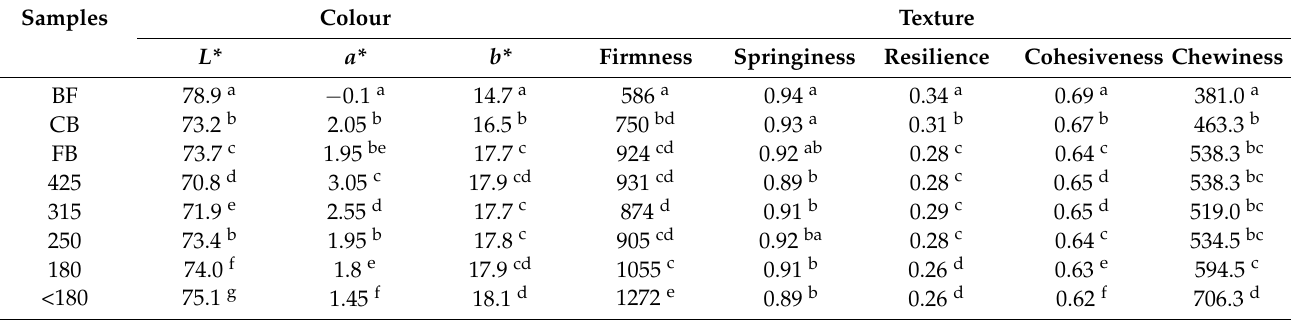
Table 4. Bread crumb colour and texture characteristics of loaves prepared from control (100% Baker’s flour, BF) and 10% incorporated bran fractions.